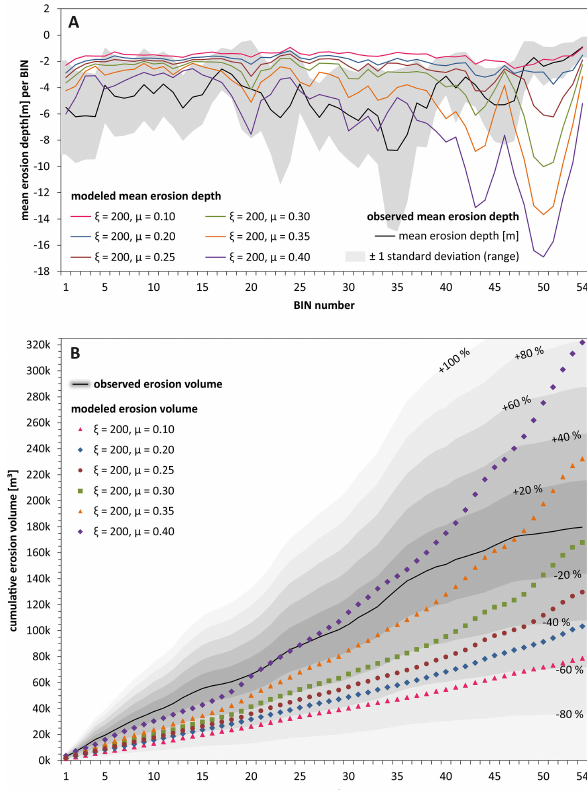
Figure 4. (a) Range of modeled compared to observed mean ero- sion depths for the two events of 2010 (Table 3). (b) Modeled cu- mulative erosion volumes compared to observed cumulative erosion volumes using the bin-based systematic analysis. The gray shaded areas depict the ranges of percental volume difference compared with the observed erosion